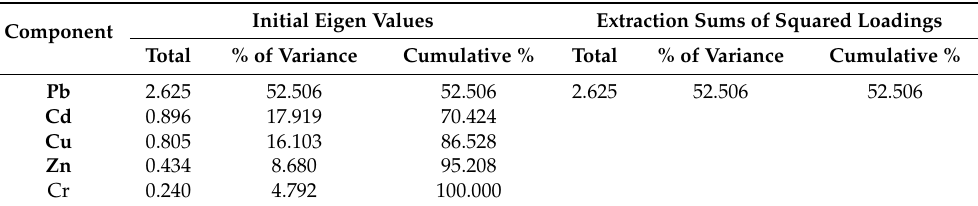
Table 11. Total variance explained.